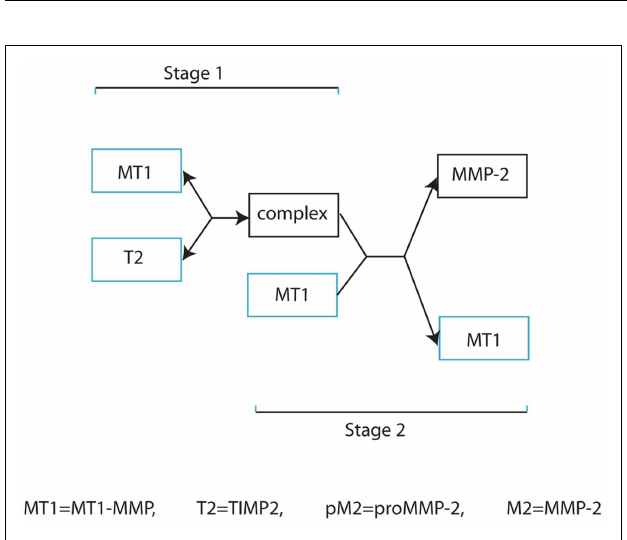
FIGURE 2 | Simplified schematic diagram of MMP-2